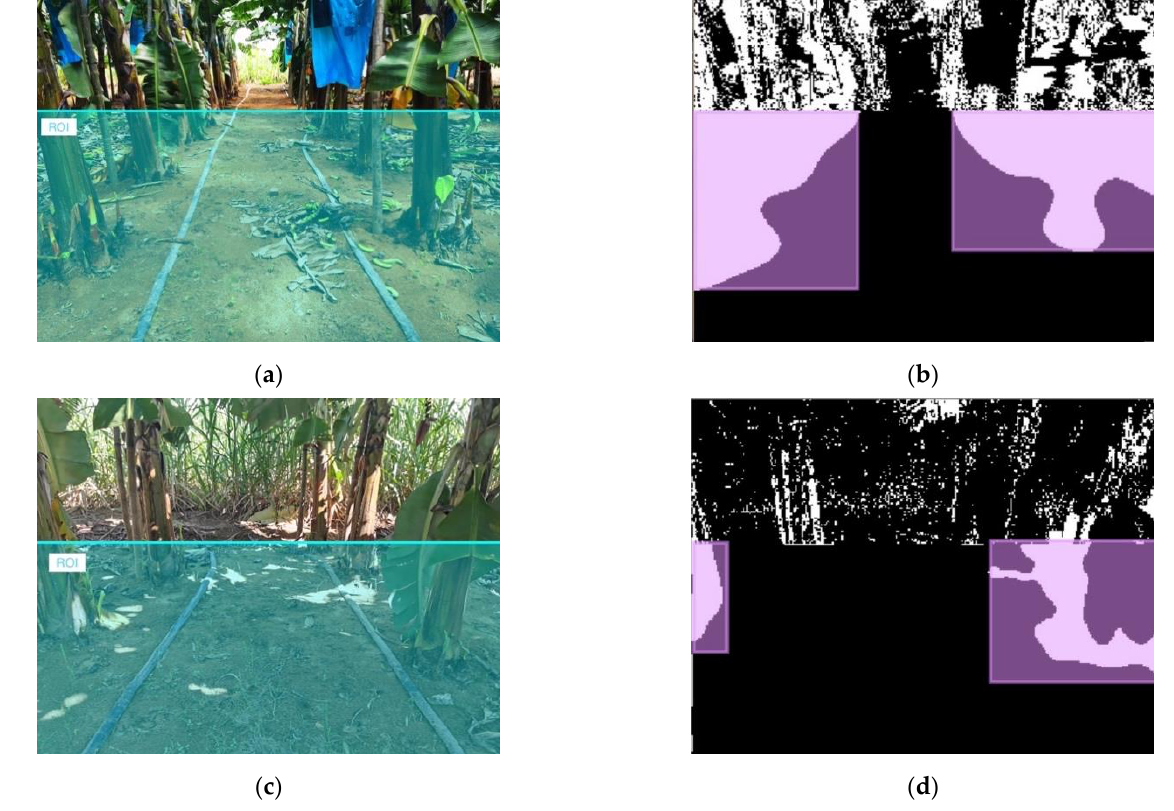
Figure 2. Row end detection based on machine vision. ( a ) Original image in the middle of the row; ( b ) binary image in the middle of the row; ( c ) original image at the end of the row; ( d ) binary image at the end of the row.